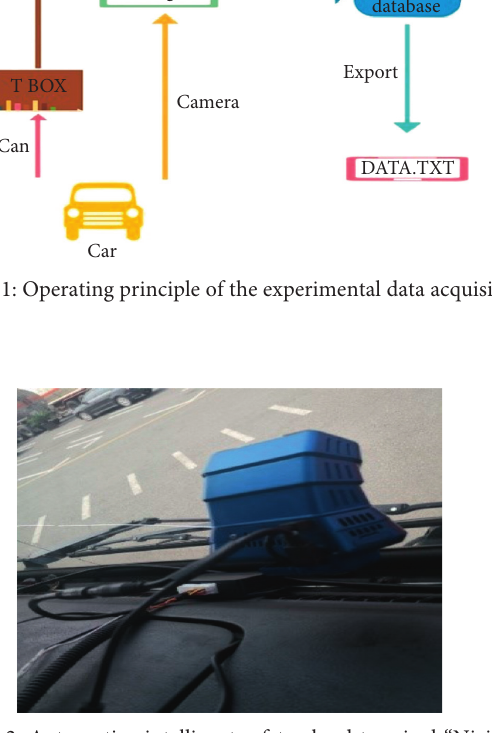
Figure 2: Automotive intelligent safety cloud terminal “Nicigo.”